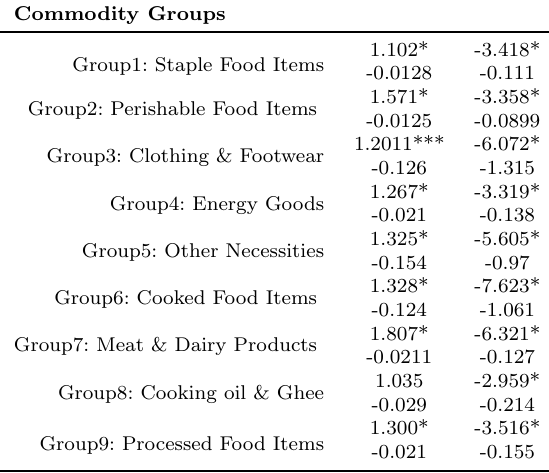
Table 5: Group-wise Estimation Results; Weibull